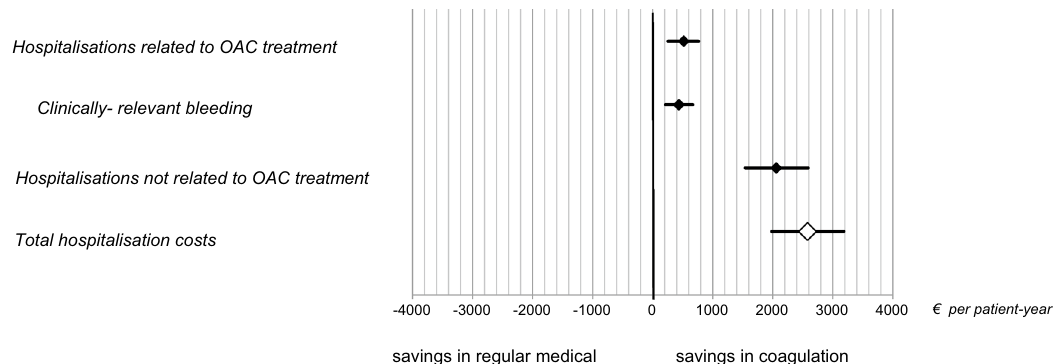
Figure 1. Net savings in hospitalisation costs per py for anticoagulation specific and non-specific